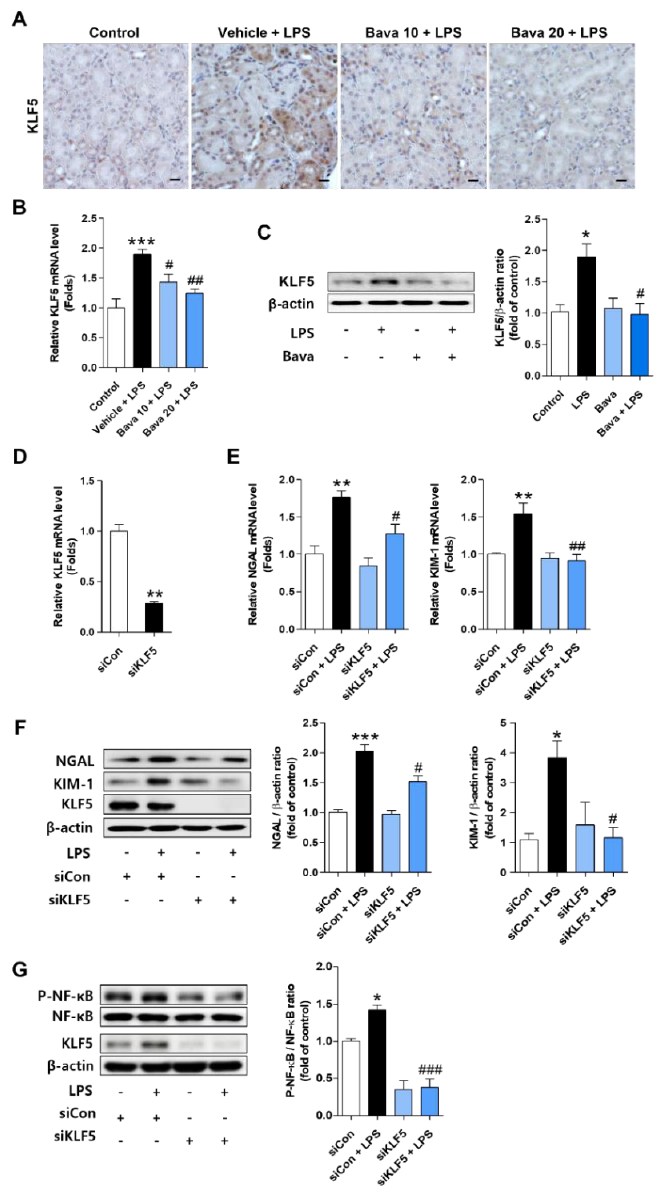
Figure 6. Bavachin decreases the expression level of kidney injury markers and NF- κ B signaling via down-regulation of KLF5 in LPS-induced AKI mice and LPS-treated HK-2 cells. ( A ) Immuno- histochemical detection of Krüppel-like factor 5 (KLF5) in kidney tissues using DAB. Nuclei were counterstained with hematoxylin (original magnification, 200 × ; scale bars, 20 µ m; n = 3 mice per group). ( B ) The mRNA levels of KLF5 in kidney tissues were analyzed by qRT-PCR ( n = 6 mice per group). ( C ) HK-2 cells were pretreated with 0.1 µ g/mL bavachin for 1 h and then treated with LPS for 1.5 h. The protein level of KLF5 was analyzed by Western blotting, quantified using ImageJ software, and normalized to β -actin. ( D – G ) HK-2 cells were transfected with scrambled siRNA (siCon) and KLF5 siRNA (siKLF5) for 6h and then treated with 1 µ g/mL LPS for another 1.5 or 15h. ( D ) The knockdown efficiencies of KLF5 siRNA in HK-2 cells were evaluated by qRT-PCR analysis. ( E ) The mRNA and ( F ) protein levels of NGAL and KIM-1 were analyzed using qRT-PCR and Western blotting, respectively. The bands were quantified using ImageJ software and normalized to β -actin ( n = 3 or 4). ( G ) The protein levels of P-NF- κ B were analyzed by Western blotting, quantified using ImageJ software, and normalized to NF- κ B ( n = 3). All data are presented as mean ± SEM. * p < 0.05, ** p < 0.01, *** p < 0.005 vs. control or siCon; # p < 0.05, ## p <0.01, ### p < 0.005 vs. vehicle + LPS or LPS or siCon +